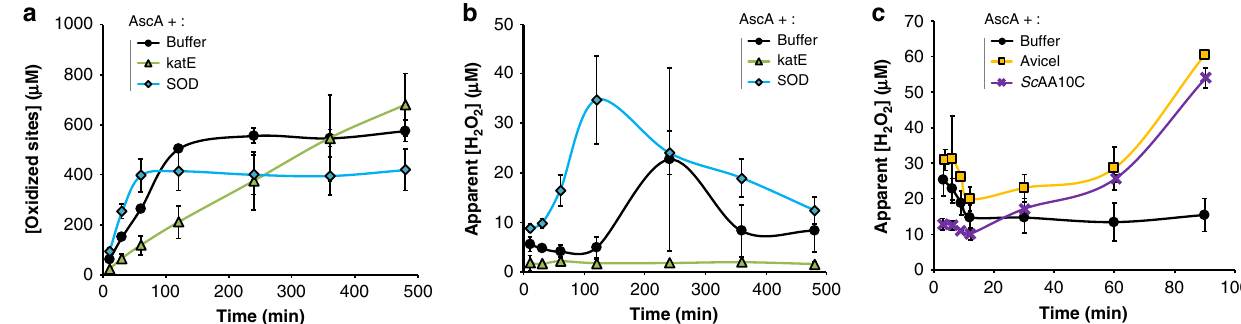
Fig. 6 Characterization of AscA-driven cellulose oxidation by Sc AA10C. The graphs show time-courses for the release of aldonic acid products ( a ) and apparent H 2 O 2 levels ( b ) upon incubating Avicel (10 g L − 1 ) with Sc AA10C (0.5 µ M) in presence of AscA (1 mM), in the dark. Reaction conditions varied in terms of the presence of SOD (0.1 µ M) and katE (10 µ g mL − 1 ). The legend code is indicated in each panel. c Apparent H 2 O 2 levels during incubation of AscA (1 mM) with either Sc AA10C (0.5 µ M) or Avicel (10 g L − 1 ) or with no addition (buffer). All reactions were carried out in sodium phosphate buffer (50 mM, pH 7.0) at 40 °C, under magnetic stirring. Before product quanti fi cation, solubilized cello-oligosaccharides were hydrolyzed by Tf Cel5A, to convert the LPMO products to a mixture of only two oxidized products with a degree of polymerization of 2 and 3 [GlcGlc1A, (Glc) 2 Glc1A], the amounts of which were summed up to yield the concentration of oxidized sites. Error bars show ± s.d. ( n = 3, independent experiments). Source data are provided as a Source Data fi